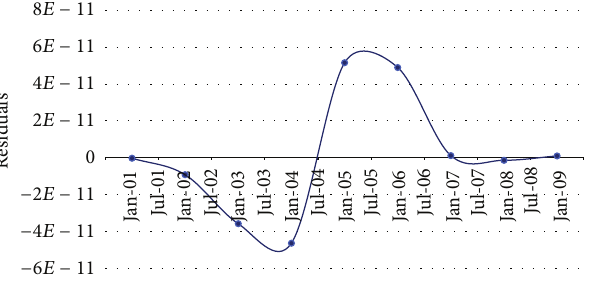
Figure 18: Residuals of the modified-hGP model in fitting for the OECD 3G mobile